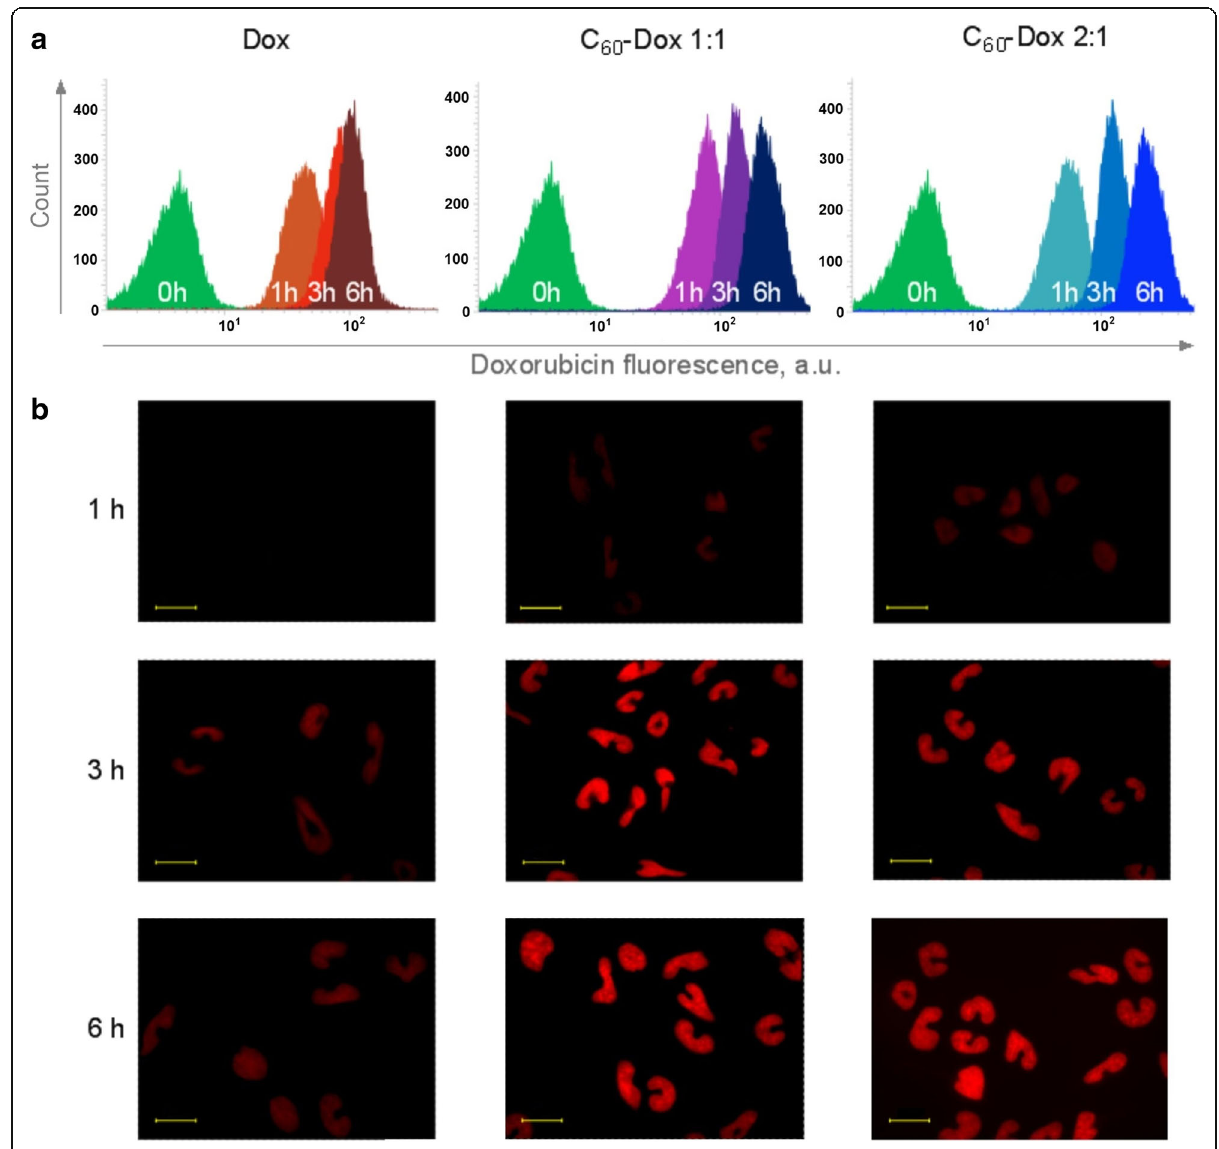
Fig. 5 Intracellular accumulation of the 1 μ M free and C 60 complexed Dox. Flow cytometry ( a ) and fluorescent microscopy images ( b ) of CCRF- CEM cells incubated with Dox and C 60 -Dox at the ratio 1:1 and 2:1 for 1, 3 and 6 h. Scale bar 20 μ M